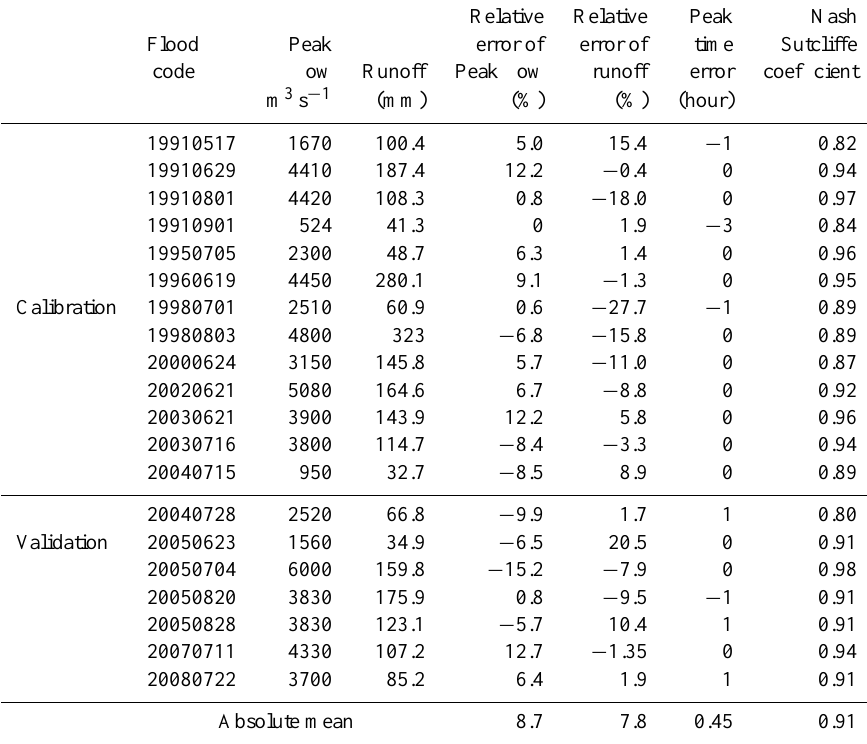
Table 2. Calibration and validation results of the Grid-Xinanjiang model in Xixian catchment. Relative Relative Peak Flood Peak